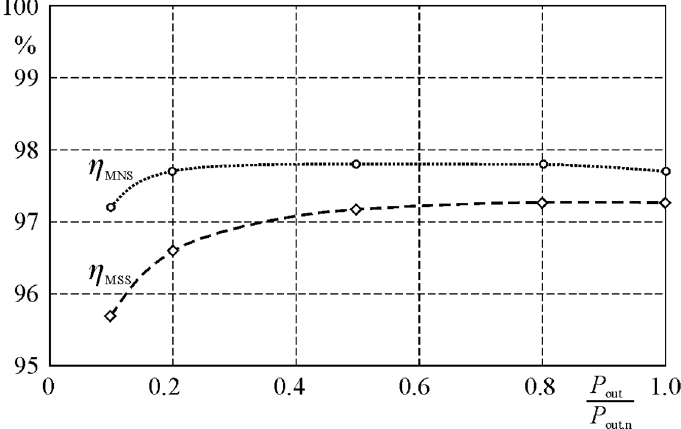
Figure 11. The calculated curves of the simulation models’ efficiency vs. the relative system’s output power for both elaborated models of rectifiers.